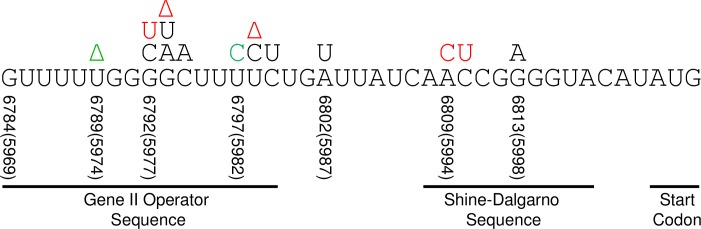
Mutations in the 5’-UTR of gene II mRNA in M13KE.The normal 5’-UTR region of the mRNA is shown, containing the gene II operator sequence, the Shine-Dalgarno sequence, and the start codon. The nucleotide numbering corresponds to M13KE. Thirteen different spontaneous 5’-UTR mutations are indicated above their respective nucleotides within the 5’-UTR (black and red). The majority of these mutations were previously reported [41], and were discovered in one of five ways: (i) in Ph.D.-7 or Ph.D.-12 phage display experiments that used Zn2+ as a target, (ii) during serial amplification of the Ph.D.-7 library, (iii) in a 135 minute screen of amplified Ph.D.-7 or Ph.D.-12 libraries, (iv) during amplification of M13KE, or (v) as a clone that contaminated a concurrent experiment in our lab. The mutations G6793T and G6792C are new to this publication, and were discovered via method (iii). The T6797C mutation was synthetically introduced using an insert containing the mutation, and was accompanied by a concomitant deletion, T6789Δ (both green). The mutations shown in red were made using a randomized synthetic insert, but had already arisen spontaneously in our experiments. Several mutations have been discovered repeatedly with different displayed peptides (or no peptide), including the two clones reported herein, Ph-VTAHGGR and Ph-SDLVLRP, which have new peptides but previously found mutations. These repeated mutations are listed here as: Mutation (Number of times observed): G6813A (4), C6810T (2), A6809C (3), T6798C (4), T6798Δ (3), G6793A (3), G6793Δ (2), G6792T (4). Two additional mutations arose through method (i) and are not shown here because they are upstream of the mRNA sequence: G6748Δ (in the gene II promoter) and C6589T (in the lacZα insert) [41].